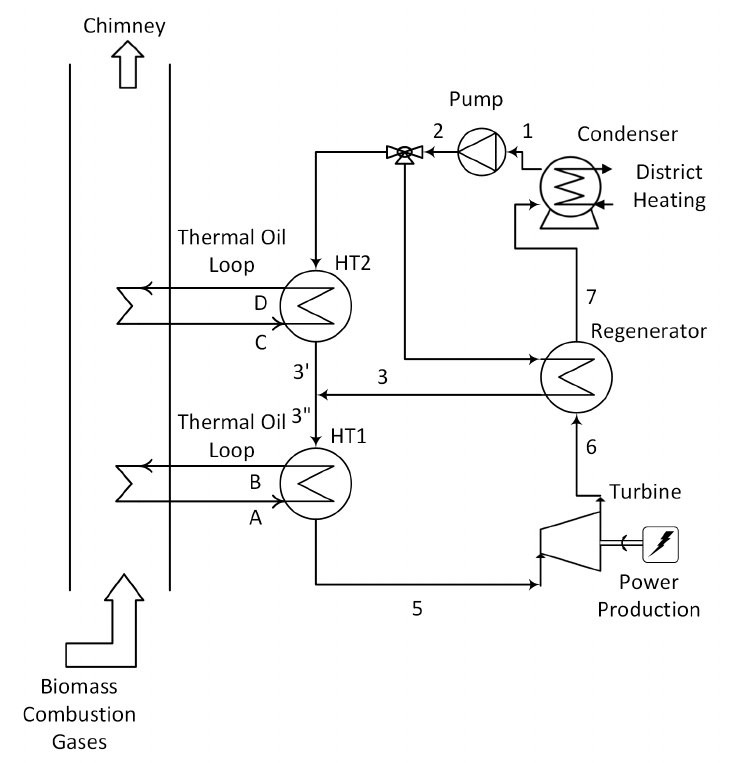
Figure 1. The reference plant scheme assumed as a reference case. Adapted from [17].